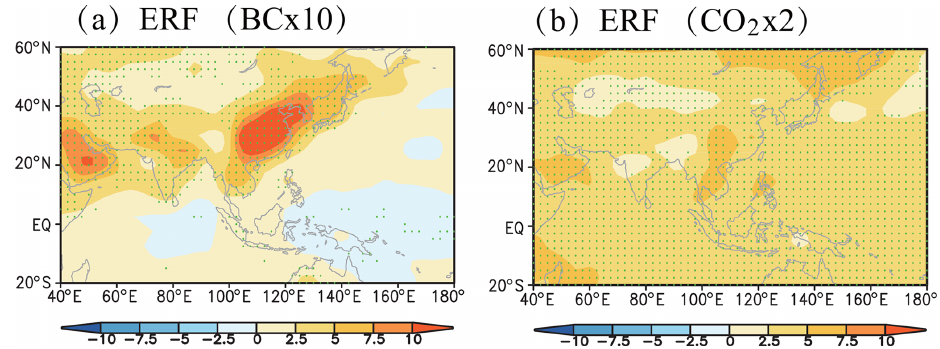
Figure 8. Multimodel mean (MMM) of the MJJAS effective radiative forcing (ERF; unit: Wm − 2 ) under (a) increasing BC and (b) GHGs. Dotted regions indicate where the MMM is more than 1 standard deviation away from 0.